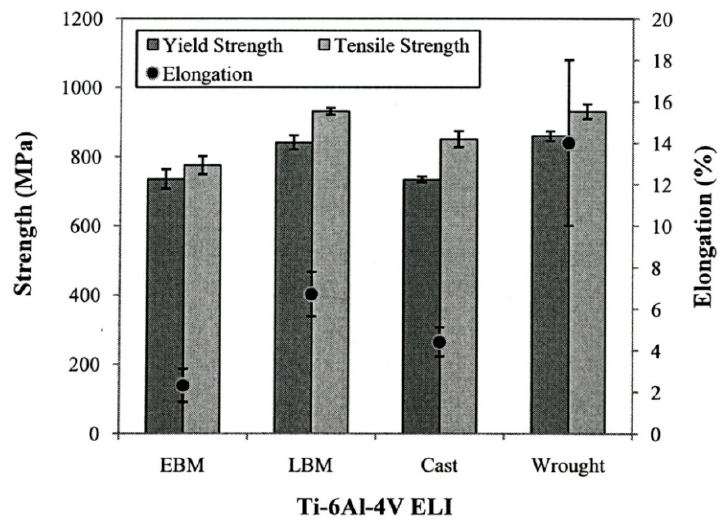
Figure 13. Mechanical properties of metals using different fabrication methods.